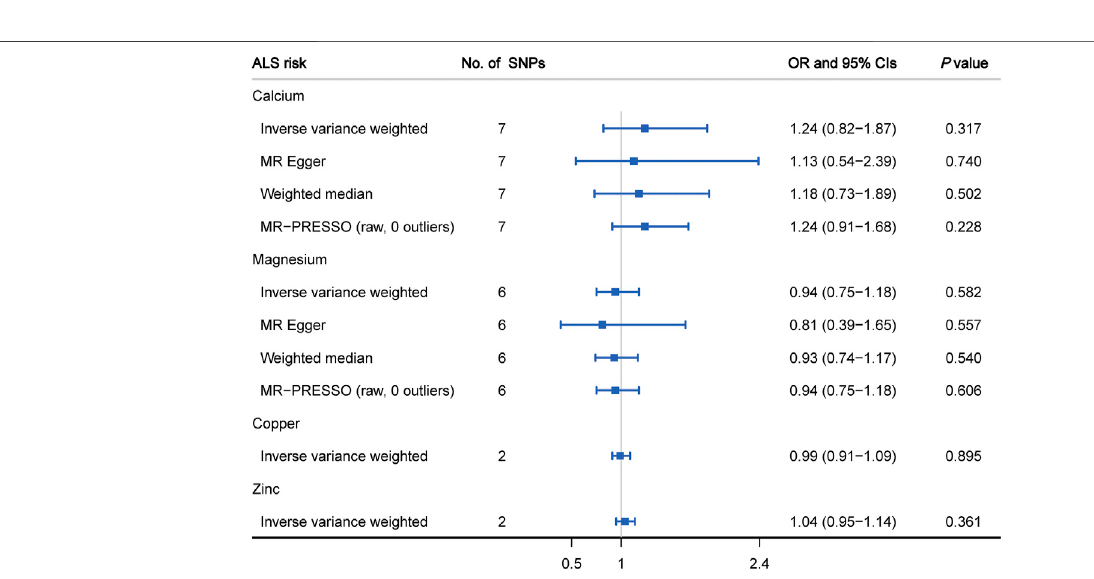
FIGURE 3 | MR analysis of genetically predicted levels of circulating minerals and ALS